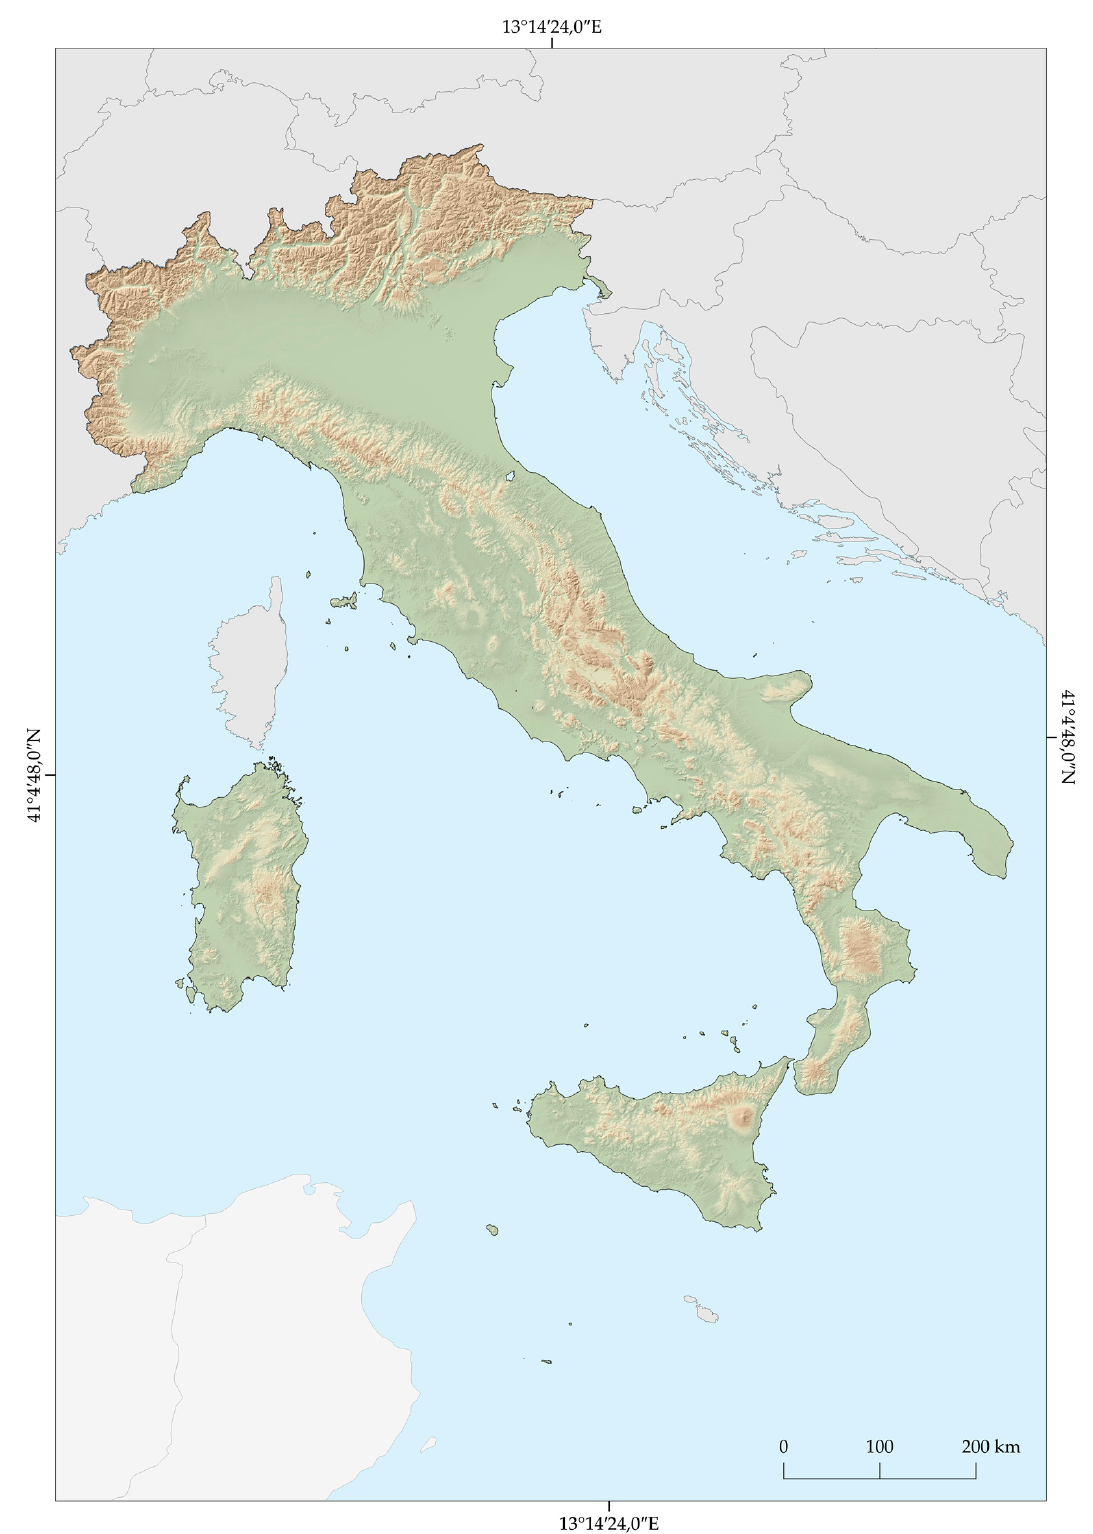
Figure 1. Study area. The analysis was conducted for the entire Italian national territory.